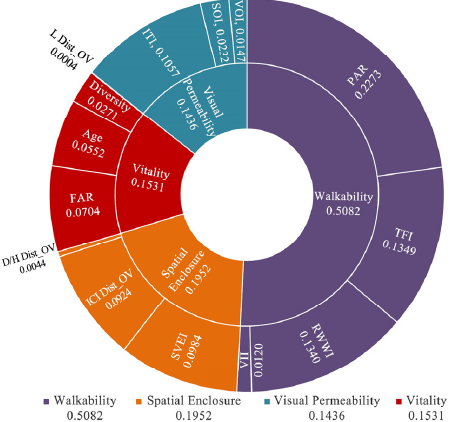
Figure 6. Index weighting results of Xiamen Island.